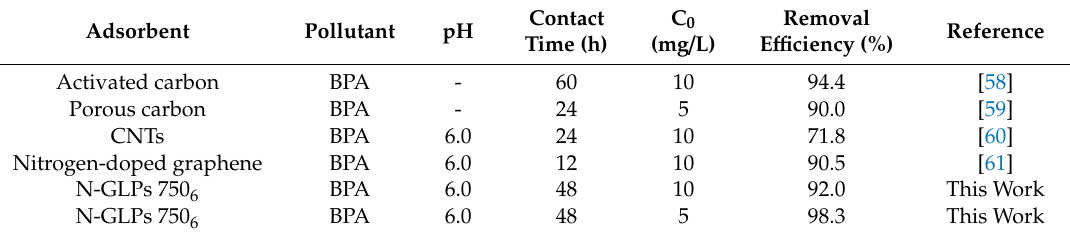
Table 3. Adsorption capacity of BPA by N-GLPs 750 6 in comparison to other literature